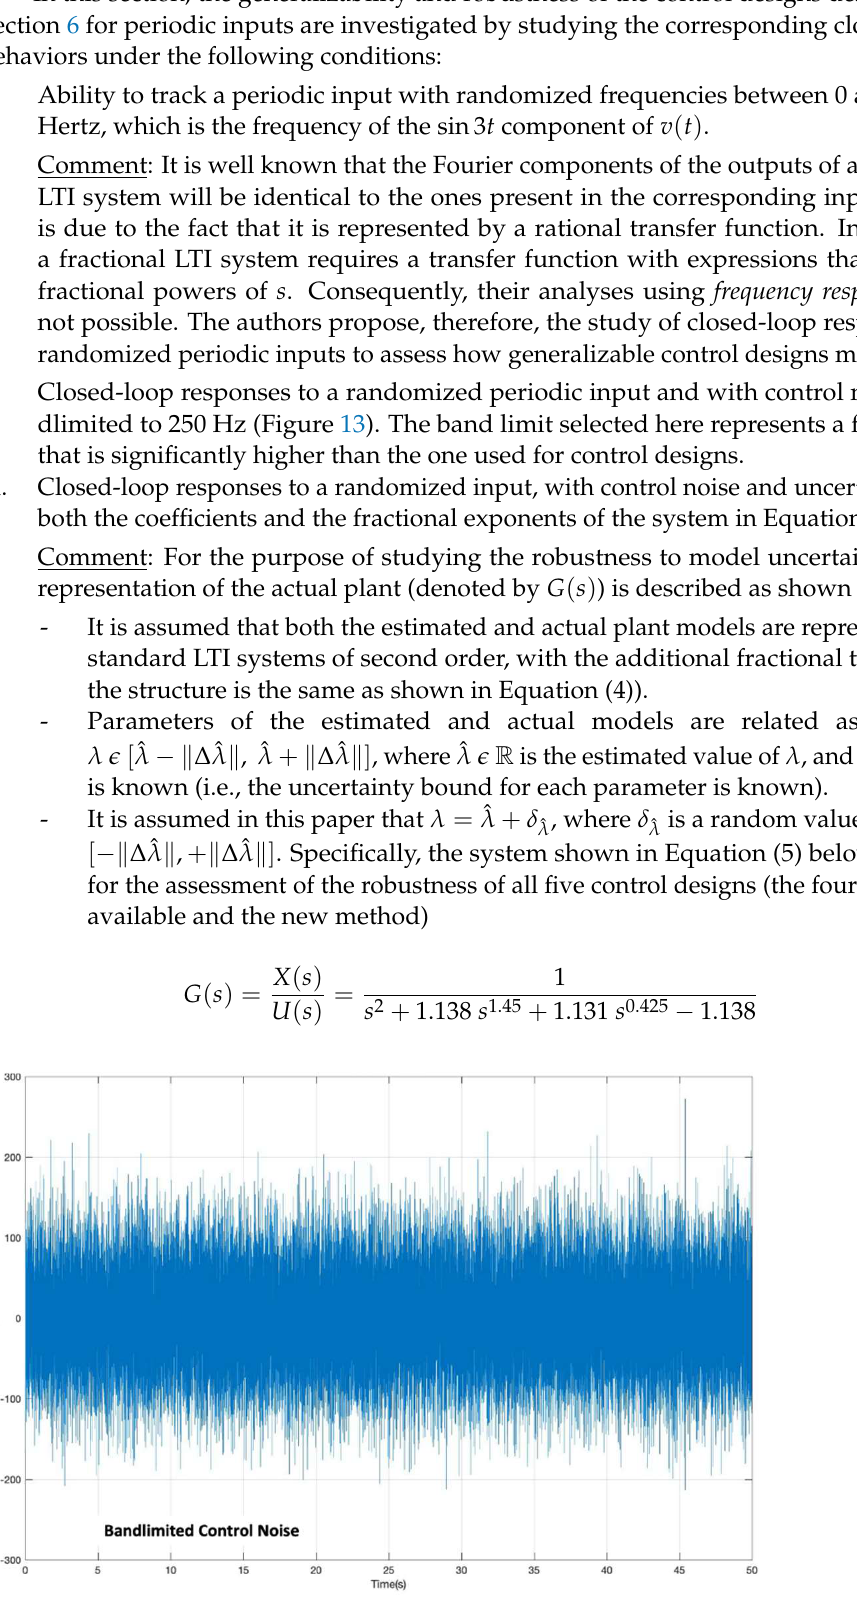
Figure 13. Bandlimited Control Noise.